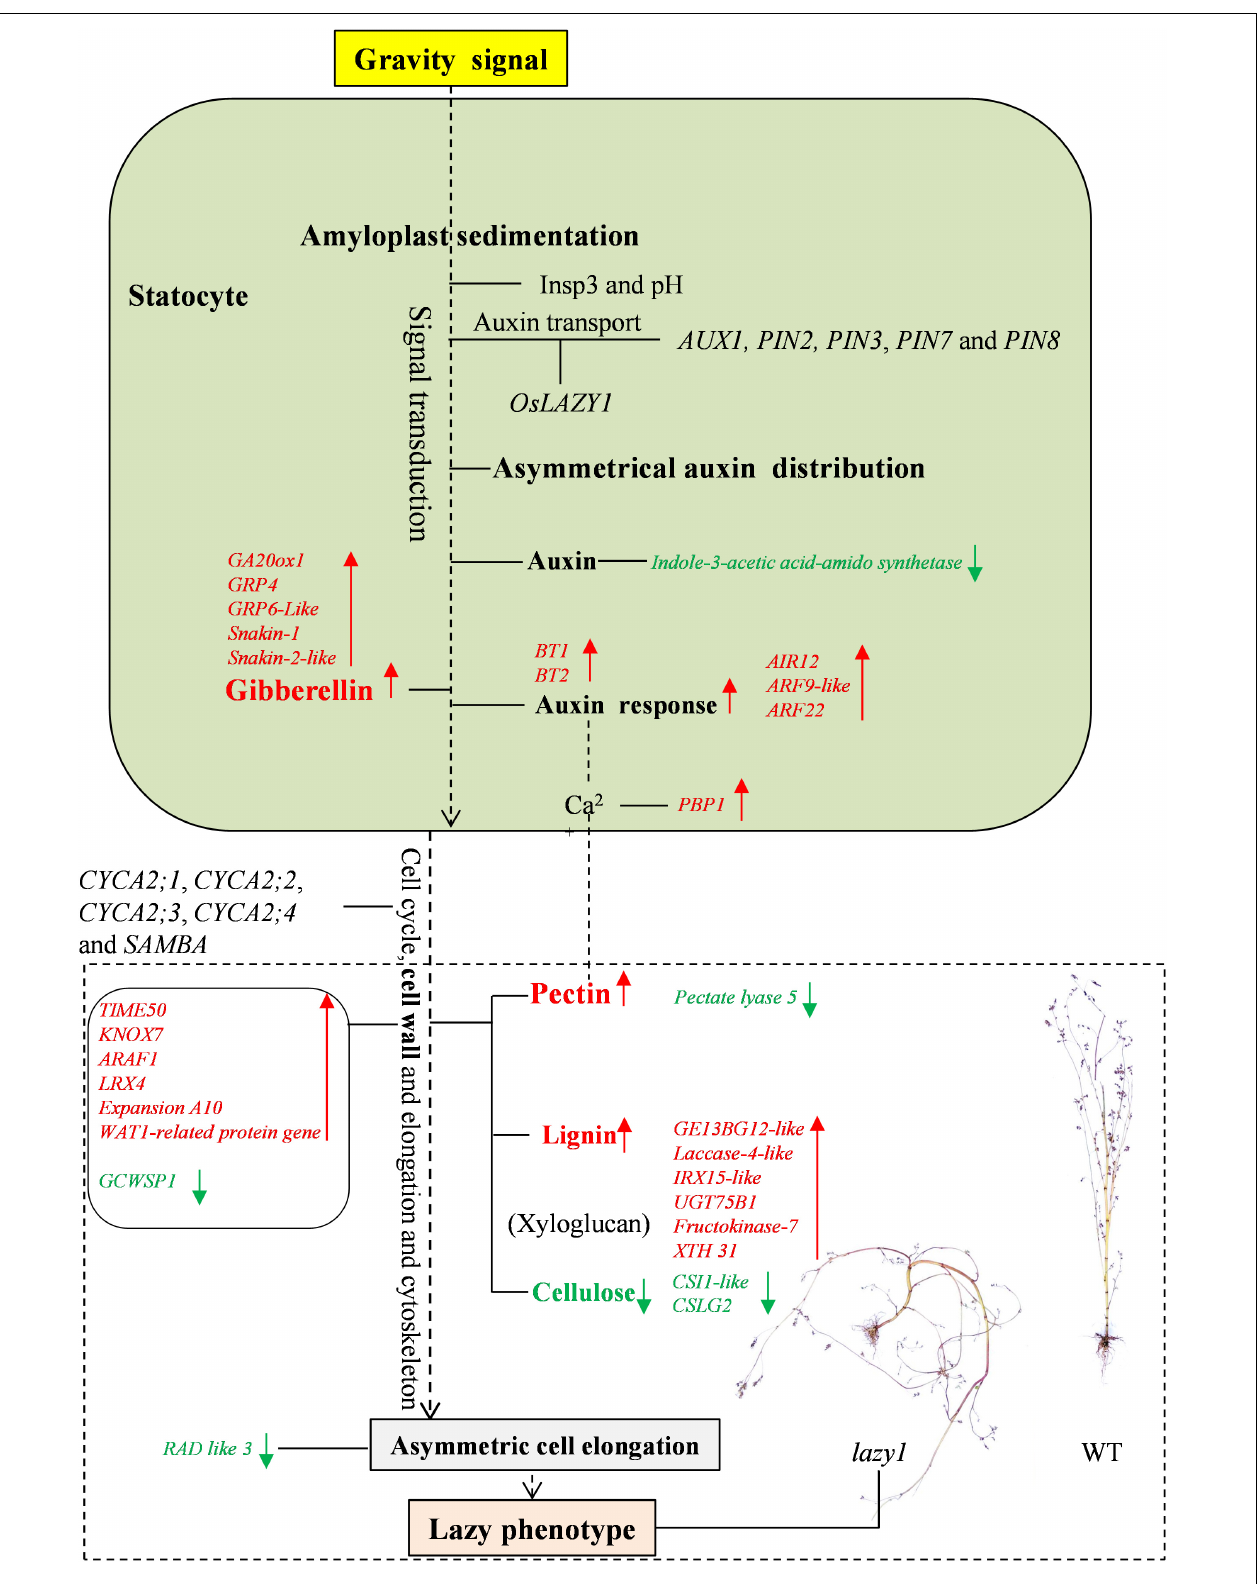
FIGURE 9 | The model for the regulation of shoot gravitropism in lazy1 based on RNA-seq and qRT-PCR. Red arrows represent the elevated contents of metabolite or up-expressed levels of gene in lazy1 . Green arrows represent the decreased contents of metabolite or down-expressed levels of gene in lazy1.